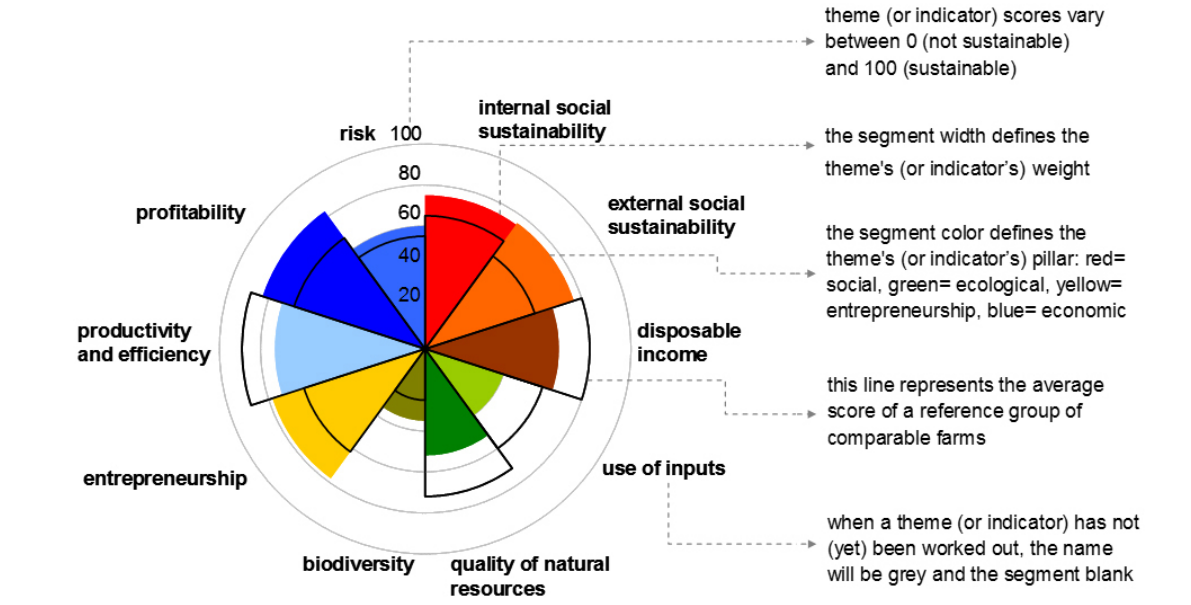
Fig. 1 . Monitoring Tool for Integrated Farm Sustainability (MOTIFS), level 1 graph and instructions on the reading and interpretation (Meul et al. 2008).